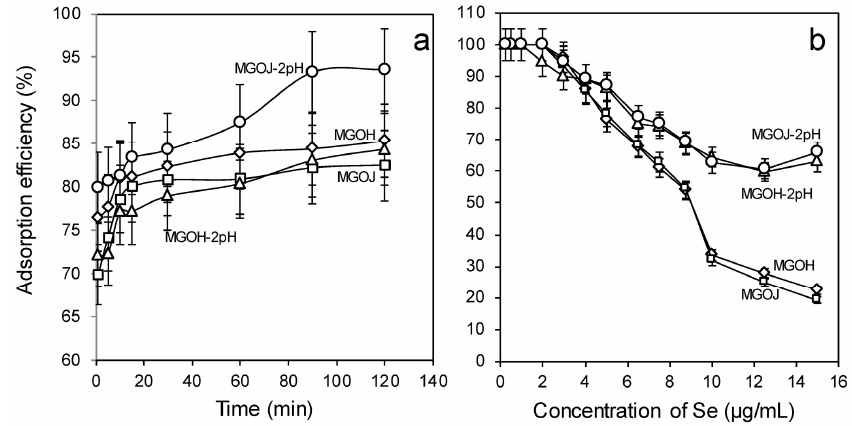
Figure 6. ( a ) The relative adsorption efficiency of Se(IV) from its solution with a concentration of 5 µ g/mL versus the contact time of 1, 5, 10, 15, 30, 60, 90, and 120 min for MPs, MGOH, MGOJ, MGOH-2pH, MGOJ-2pH; and ( b ) The effect of Se(IV) concentration on the adsorption efficiency for different materials MGOH, MGOJ, MGOH-2pH, and MGOJ-2pH. Table 2. The relative values of the adsorption efficiency from a solution with Se(IV) concentration of 5 µ g/mL for MPs, GOH, GOJ, MGOH, MGOJ, MGOH-2pH, and